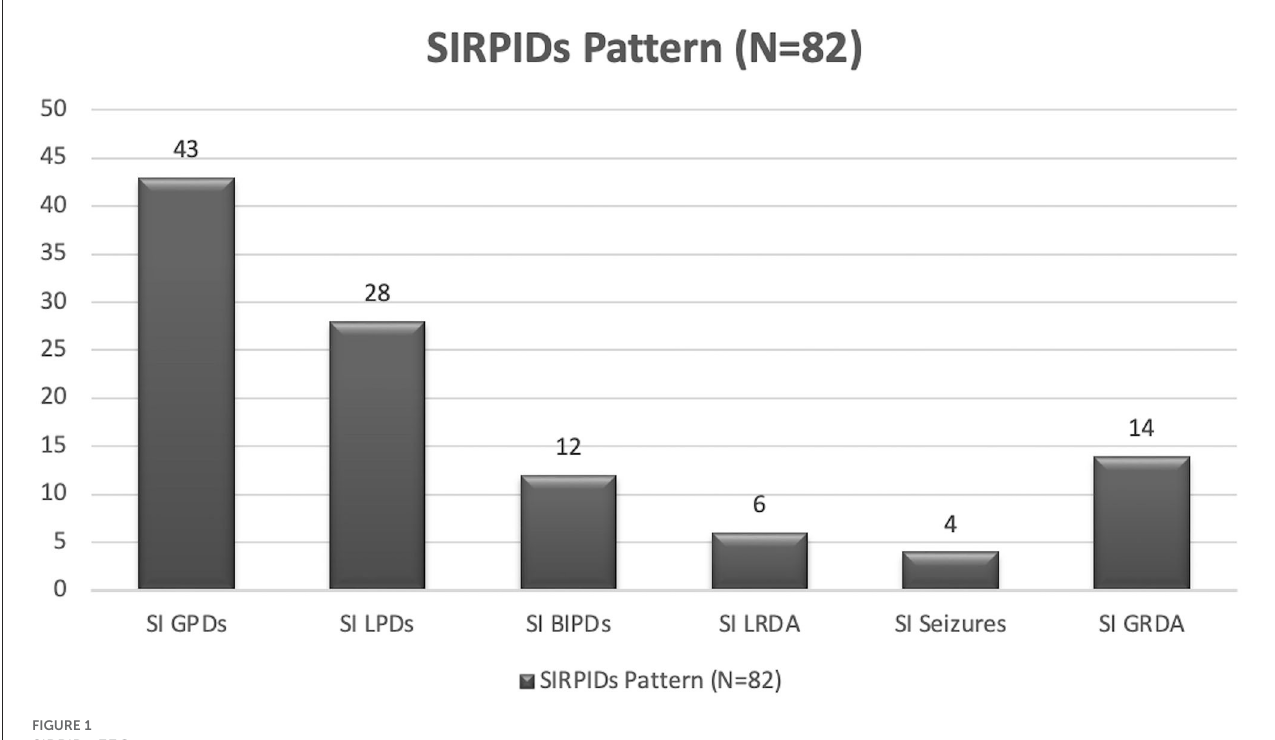
FIGURE1 SIRPIDs EEG patterns.